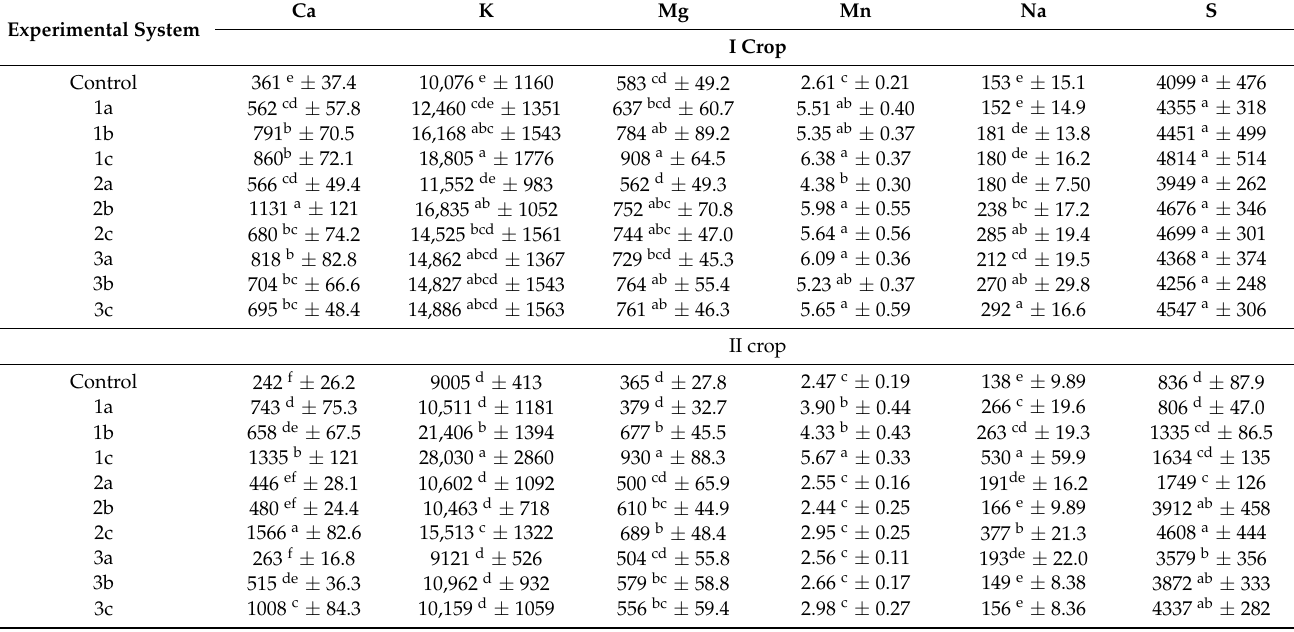
Table 1. Content (mg kg − 1 DW) of selected elements in Pleurotus eryngii fruit bodies after the I and II crop.